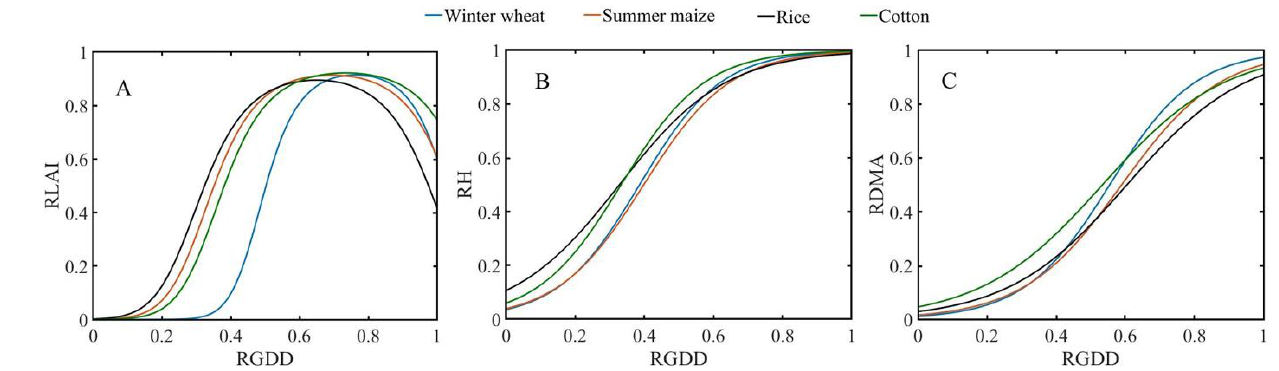
Figure 4. Fully relative logistic curves for each crop for ( A ) RLAI, ( B ) RH, and ( C ) RDMA.